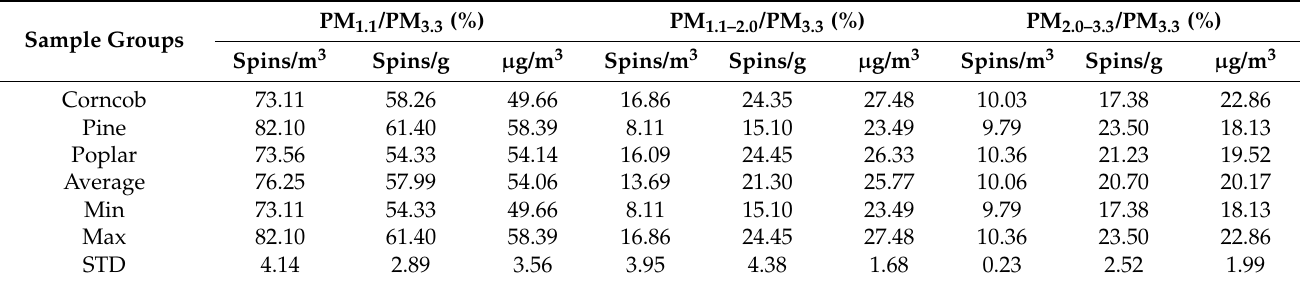
Figure 1. EPFRs and PM concentrations in biomass combustion particles from Xuanwei (the left : the atmospheric EPFRs concentrations; the right : EPFRs concentrations in PM). Table 2. Size distribution of EPFRs and PM in simulated biomass combustion particles from Xuanwei (%). Sample